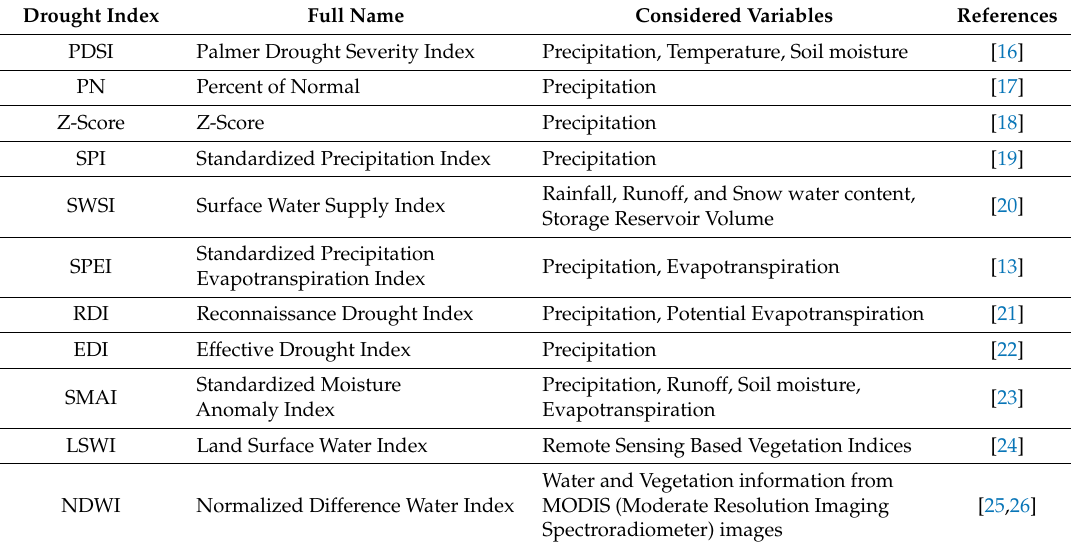
Table 1. Descriptions of different drought indices